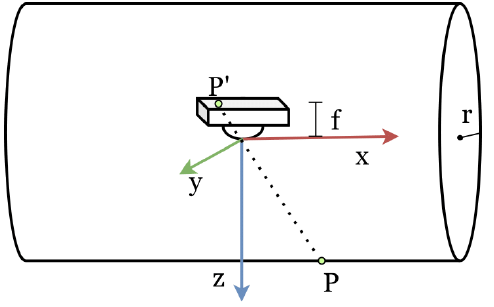
Figure 3. The geometrical model of the TouchRoller tactile sensor. The sensor was modelled as a cylinder with a radius of r . A camera with focal length f was placed in the centre of the cylinder, and a point P on the surface of the cylinder was mapped to P (cid:48) in the tactile